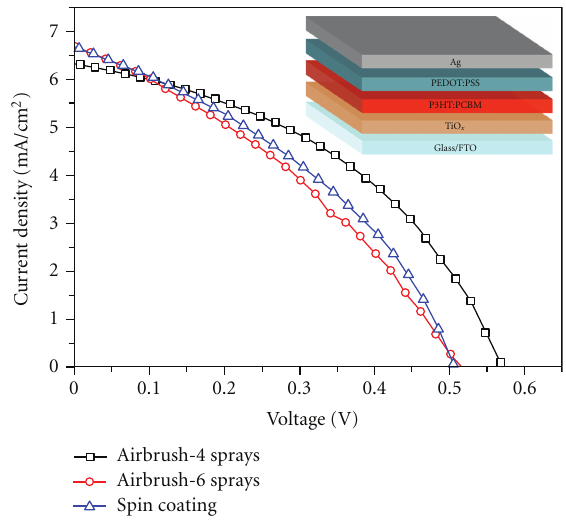
Figure 5: J - V characteristics of a device with TiO x deposited by airbrush 4 sprays ( (cid:2) ) and airbrush 6 sprays ( (cid:5) ) compared with a device with TiO x realized by spin coating ( (cid:3)